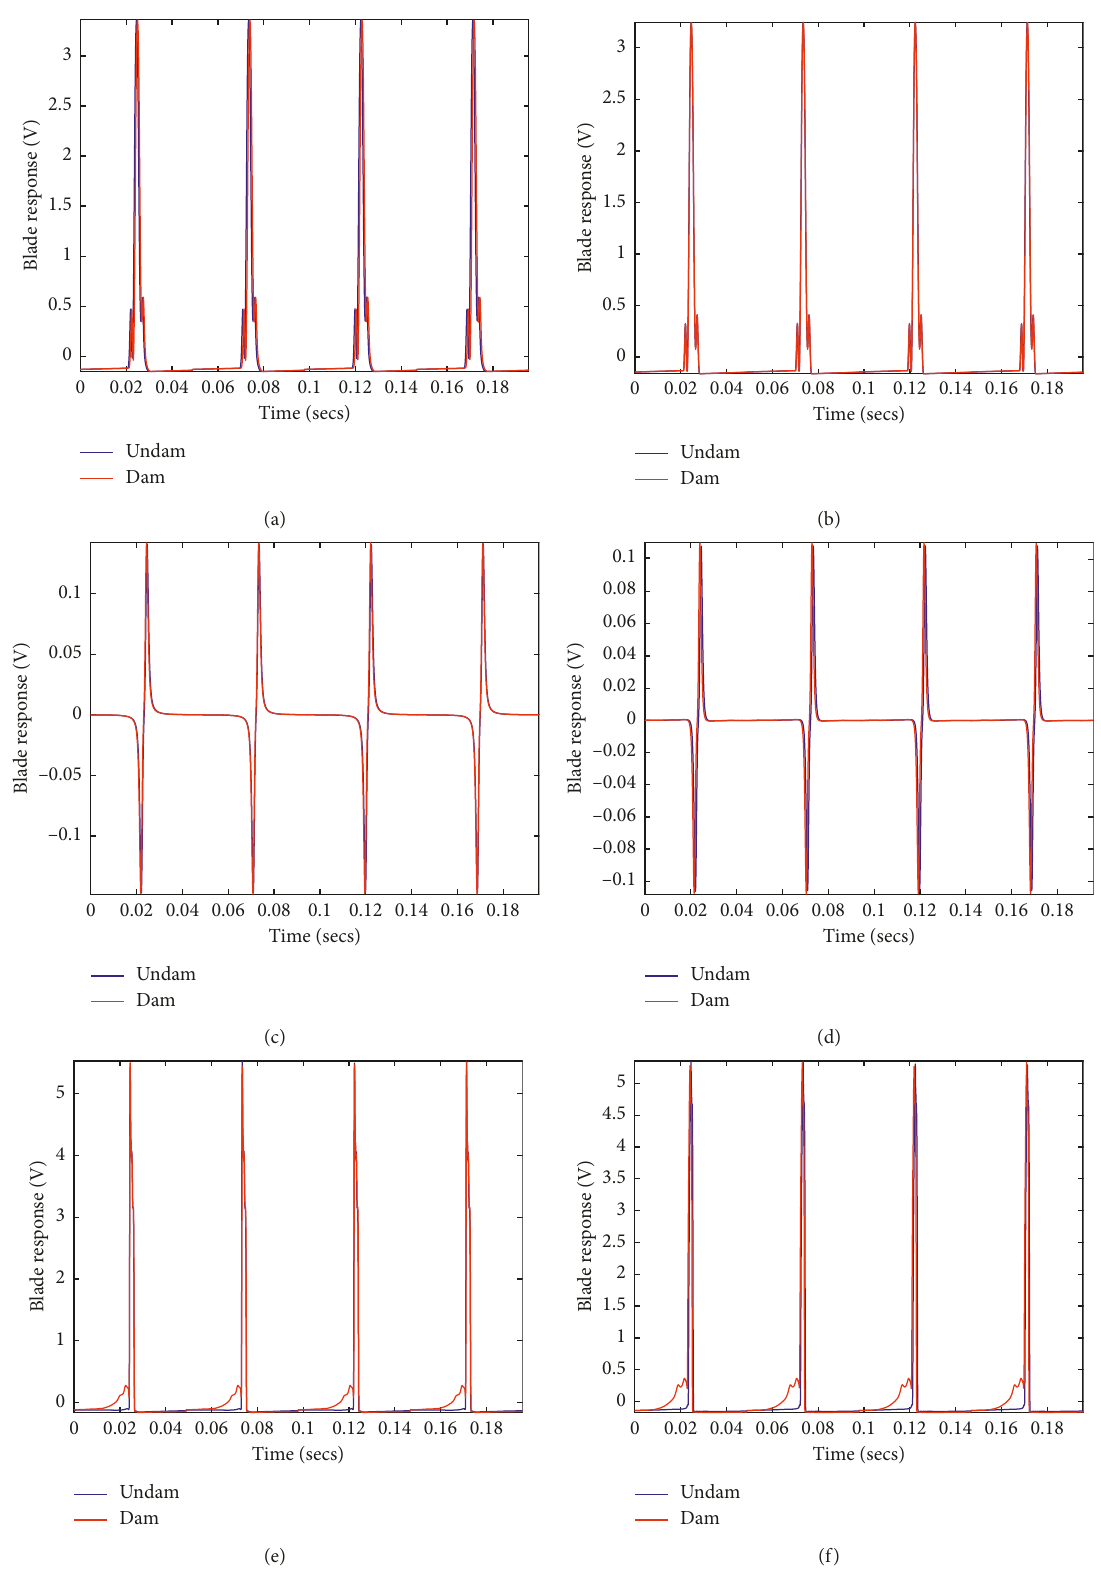
Figure 18: Reconstructed BTTsignals of undamaged and damaged cases of blades 4 and 8 from (a, b) AECS, (c, d) PECS, and (e, f) optical sensor,